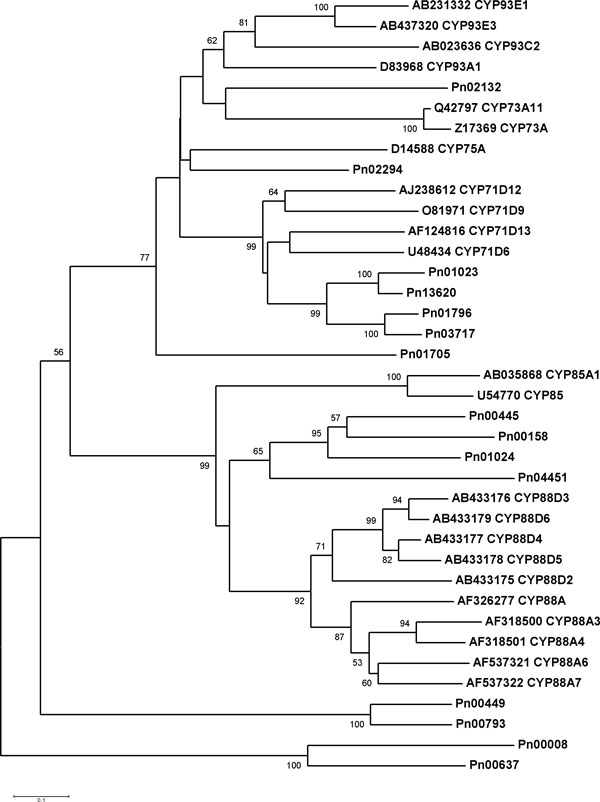
Phylogenetic analysis of full-length CYP450s from P. notoginseng and characterized CYP450s from other plants. Amino acid sequences were aligned using the CLUSTALW program, and evolutionary distances were computed using MEGA4 with the Poisson correction method. Bootstrap values obtained after 1000 replications are indicated on the branches. Values less than 50% are not shown. The GenBank/EMBL/DDBJ accession numbers of the sequences are: U48434 (Solanum chacoense), O81971 (Glycine max), AJ238612 (Catharanthus roseus), AF124816 (Mentha × piperita), Z17369 (Helianthus tuberosus), Q42797 (Glycine max), D14588 (Petunia × hybrida), AB035868 (Arabidopsis thaliana), U54770 (Solanum lycopersicum), AB433175 (Medicago truncatula), AB433176 (Medicago truncatula), AB433177 (Lotus japonicus), AB433178 (Lotus japonicus), AB433179 (Glycyrrhiza uralensis), AF537321 (Pisum sativum), AF537322 (Pisum sativum), AF318500 (Arabidopsis thaliana), AF318501 (Arabidopsis thaliana), AF326277 (Hordeum vulgare), AF135485 (Glycine max), AB231332 (Glycine max), AB023636 (Glycyrrhiza echinata), AB437320 (Glycyrrhiza uralensis), D83968 (Glycine max), X71657 (Solanum melongena), X71658 (Solanum melongena), X71656 (Solanum melongena), X71655 (Solanum melongena), L23209 (Zea mays), NM_001112599 (Zea mays), U29333 (Pisum sativum), U69134 (Arabidopsis thaliana), U18929 (Arabidopsis thaliana), AF150881 (Solanum lycopersicum × Solanum peruvianum), AF214008 (Brassica napus), U38416 (Arabidopsis thaliana), AF029856 (Sorghum bicolor), AF029858 (Sorghum bicolor), AJ583531 (Triticum aestivum).